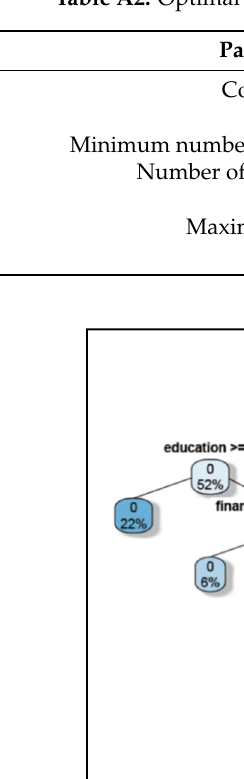
Table A2. Optimal tuning parameters for DT, RF and GBM algorithms.